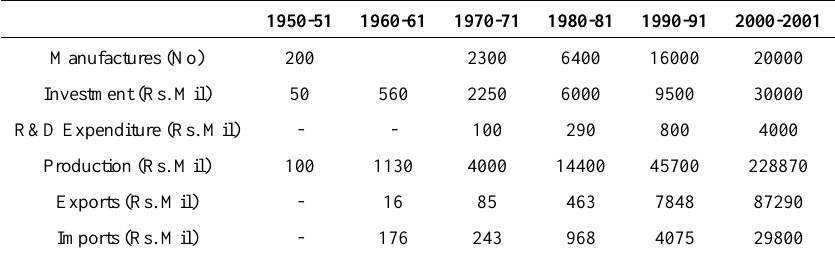
Table 2. Indian Pharmaceutical Market